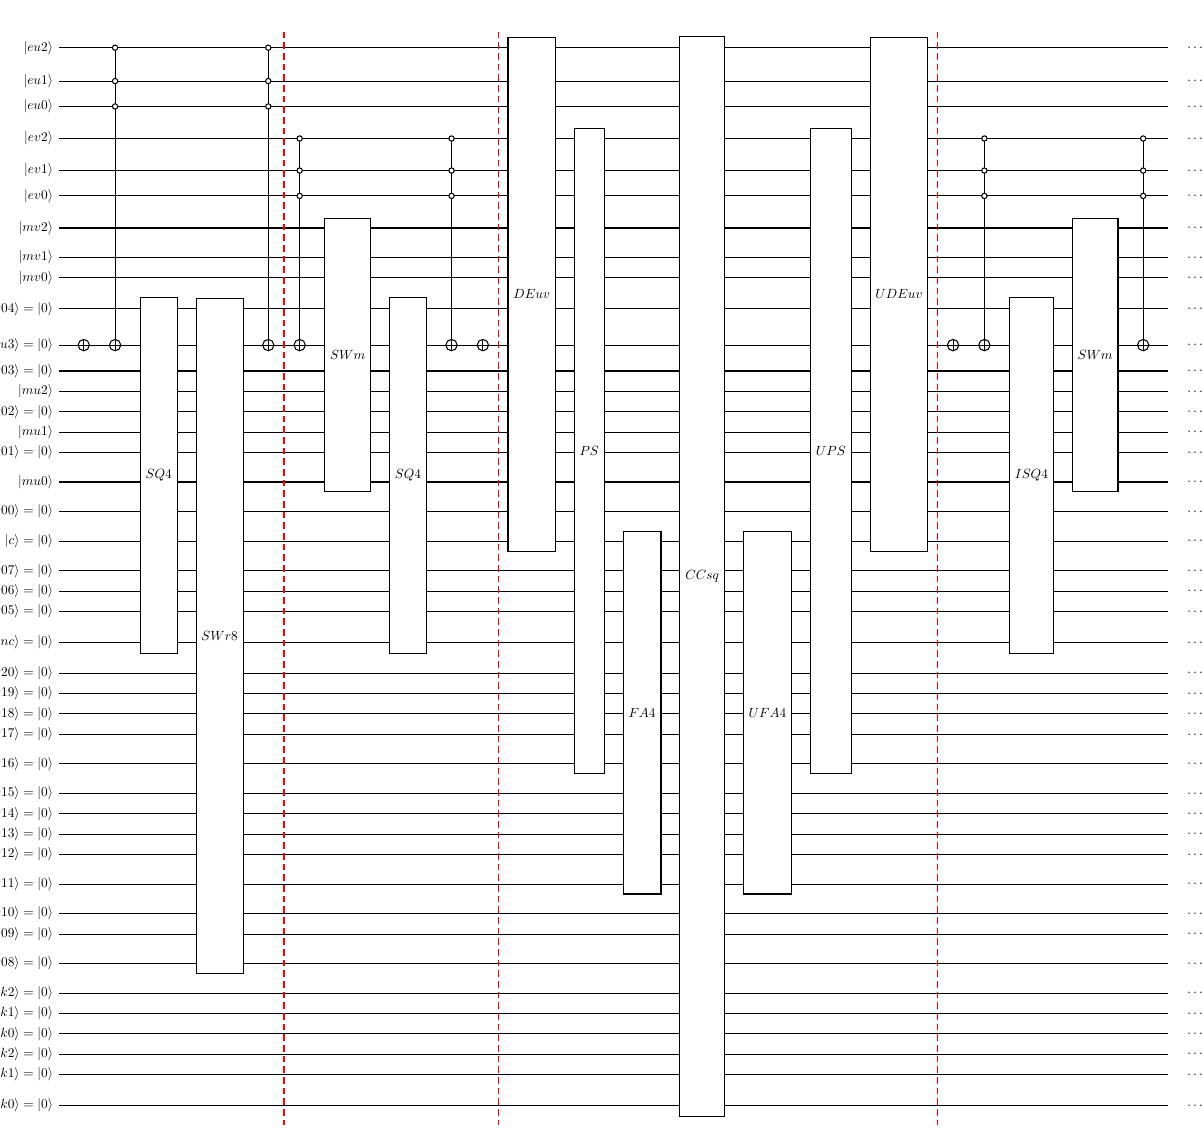
Figure 9. Quantum circuit design Ekin2D2 for computation of u 2 + v 2 . The floating-point representa- tion uses four mantissa qubits ( N M = 4) and three exponent qubits ( N E =